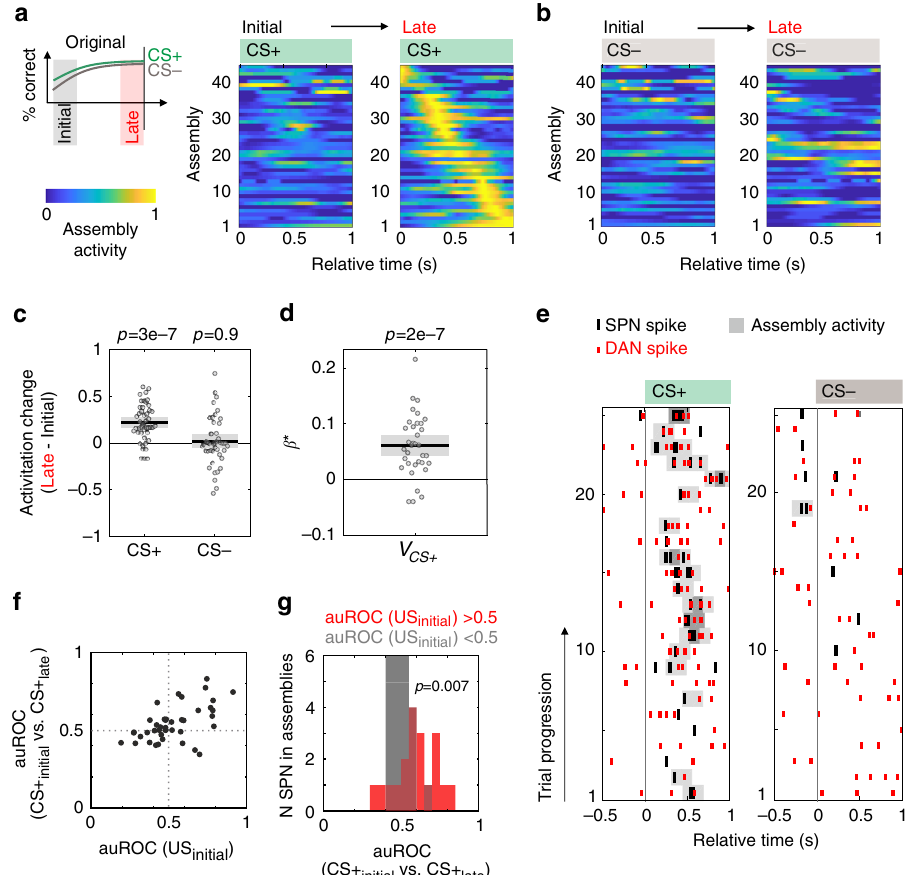
Fig. 5 SPN – DAN assemblies emerge with learning. a , b Activity of directional SPN – DAN assemblies after CS + and CS − onset. To capture learning, activity was separately averaged for the 12 initial and 12 late trials (original phase). Same normalization for each assembly across the four panels. c Difference in mean activity between late and initial trials of directional assemblies at CS (original phase, two-sided Wilcoxon test, n = 45, data displayed as mean ± S.E.). Throughout this fi gure: CS window = 0 – 0.7 s from CS onset. d Standardized and transformed β * coef fi cients of the Poisson regression of assembly activity at CS + on the subjective value V CS + ( t ) assigned by the animal to CS + at each trial of the original and reversal phase. V CS + was estimated from the behavioral data with a Q-PH f reinforcement learning model (see Methods). β * coef fi cients were greater than zero (two-sided t -test), con fi rming a positive correlation between SPN – DAN assembly activity and value assignment. Regression performed on all SPN – DAN assemblies. Among the 31 assemblies with positive β *, 26 had lag>0. Only signi fi cant β * displayed ( n = 35, data displayed as mean ± S.E.). e Peri-stimulus raster plot of a SPN and a DAN forming an assembly correlated with V CS + (assembly activity shown in gray, darker = stronger activation). Assembly with Δ = 0.12 s and lag l ¼ 1 Δ : CS þ (SPN preceding DAN). f For SPN participating in SPN – DAN assemblies, the plasticity at CS + ( auROC ð CS þ ) was compared with the initial initial vs late Þ activity of SPN at US ( auROC ð US ). Each data point marks the mean auROC of spike counts in the original and reversal phase of one SPN. initial Þ : CS þ for SPN with excitatory ( auROC ð US >0.5) or inhibitory ( auROC ð US <0.5) response to US. SPN g Distributions of auROC ð CS þ initial vs late Þ initial Þ initial Þ with an excitatory response to US in the initial trials showed a reinforced response to CS + in the late trials (two-sided Wilcoxon test). Source data are provided as a Source data fi le. See also Supplementary Figs. 9 –